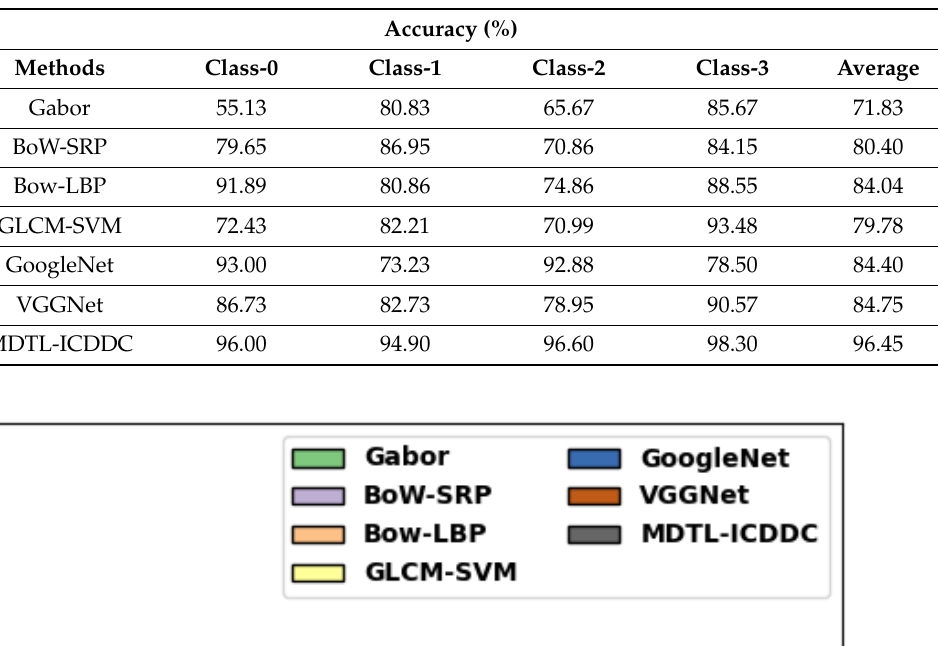
Table 5. Accuracy analysis of MDTL-ICDDC technique with existing algorithms under various classes.